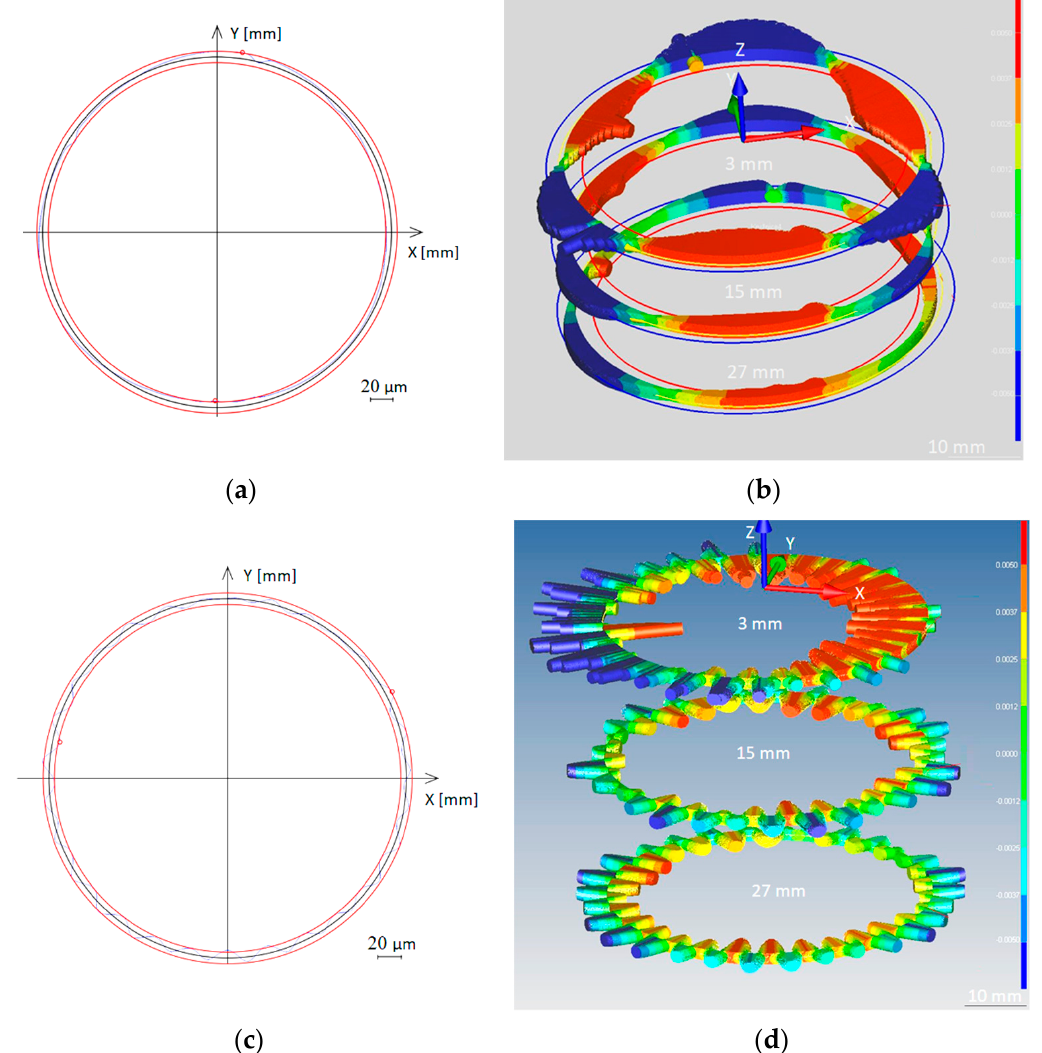
Figure 8. Circularity profile of the workpiece when cutting with a carbide boring bar: ( a ) in stable condition in 2D; ( b ) in stable condition in 3D at TSC = 4 mm − 1 ; ( c ) unstable condition in 2D; ( d ) unstable condition in 3D at TSC = 13.50 mm − 1 .